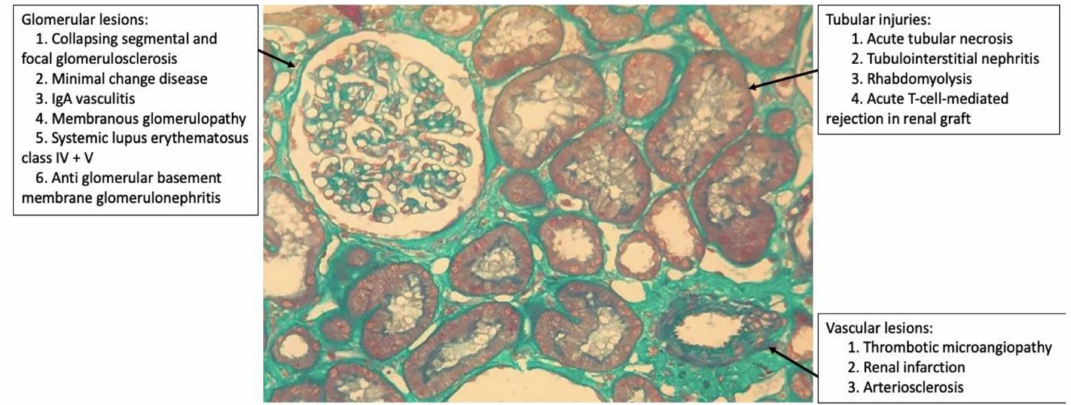
Figure 1. Histopathological patterns of renal lesions by SARS-CoV-2 (glomerular, tubulointerstitial, and